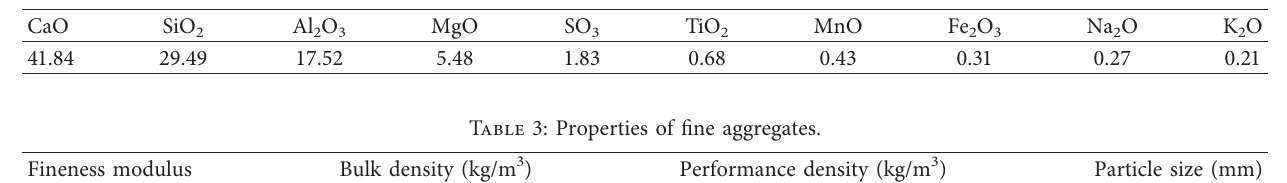
Table 2: Main chemical content of slag (%).